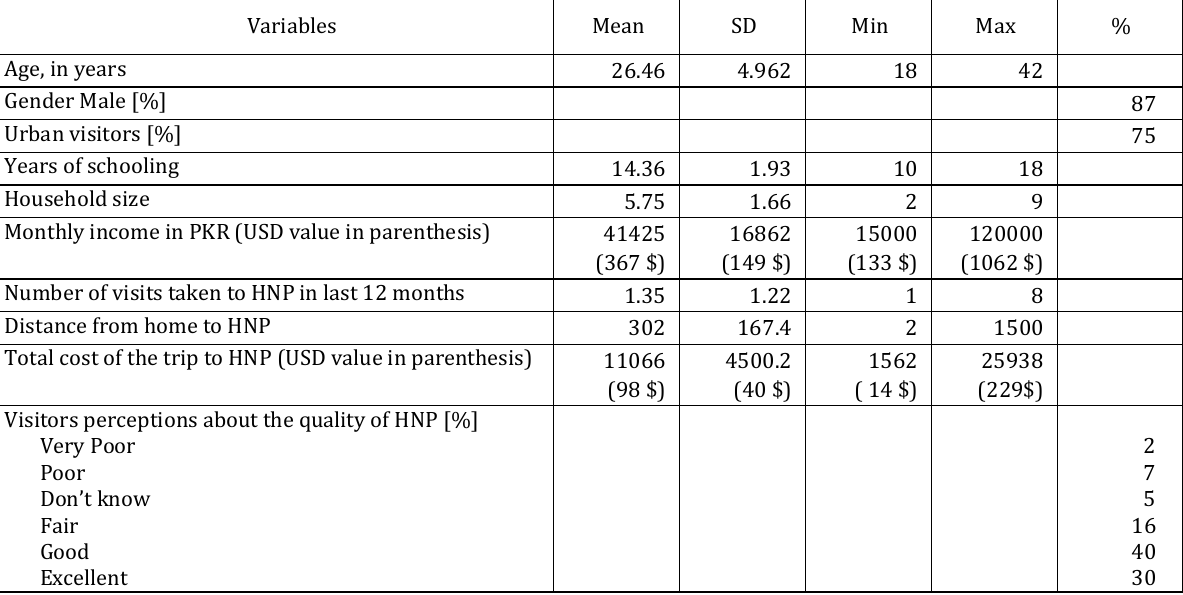
Table 2. Characteristics of visitors